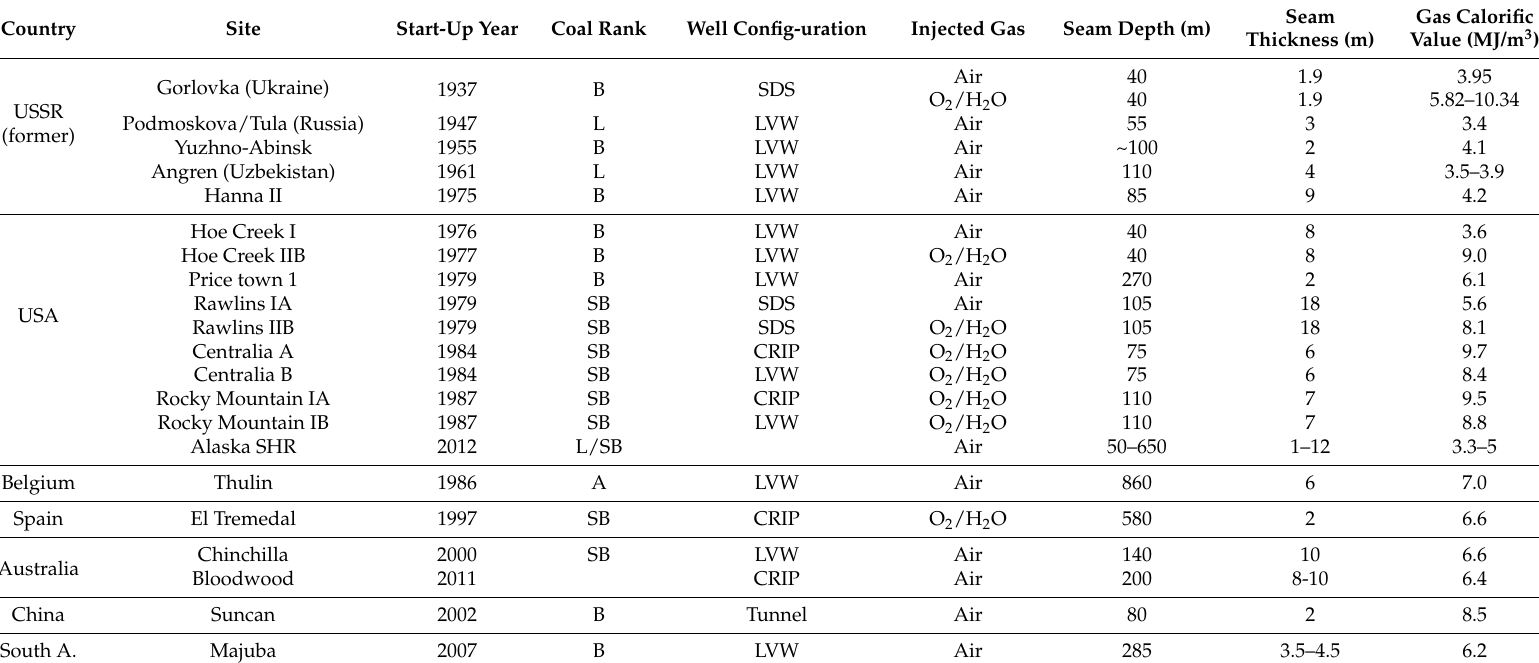
Table 2. Summary of significant underground coal gasification (UCG) field trials worldwide